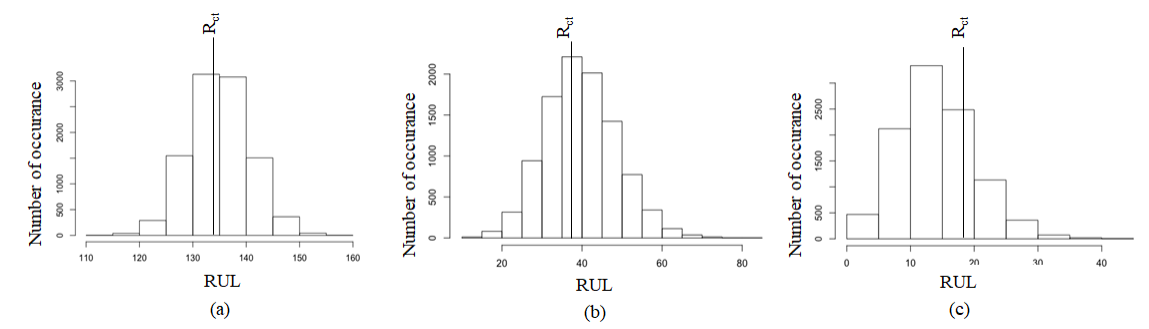
Figure 13. Position of the real crossing time R ct compared to the histograms of RUL for real data with the KNN algorithm: